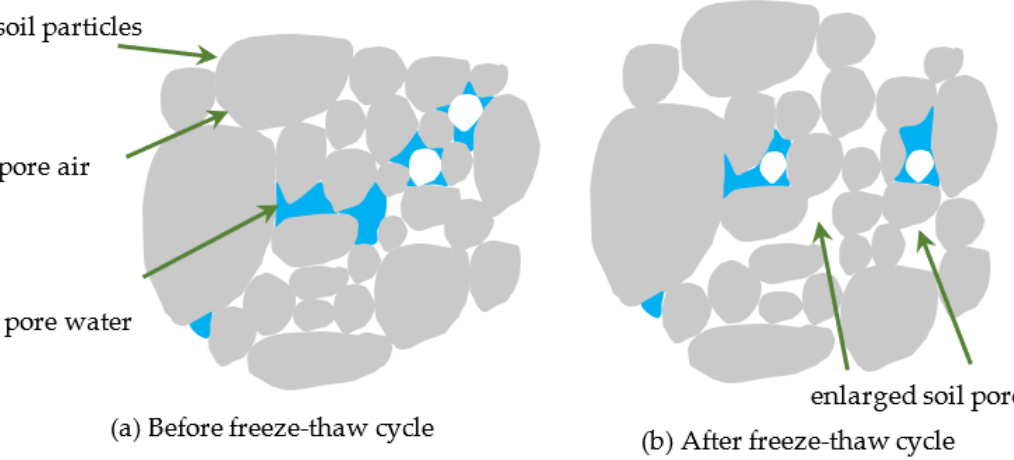
Figure 8. Interfacial mechanical interaction sketch of NSF.